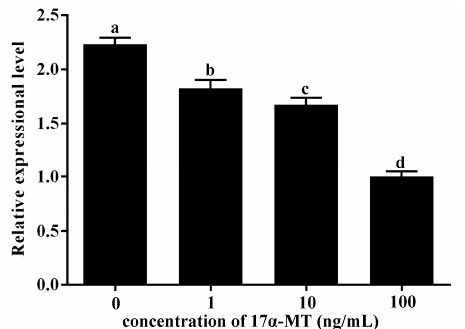
Figure 9. Expression of CYP19A1 mRNA in P. olivaceus testis cells stimulated with 1, 10 and 100 ng/mL 17 α -MT. qRT-PCR analysis was used to quantify CYP19A1 mRNA with β -actin as a reference. The relative expression variance is presented as a ratio (amount of CYP19A1 mRNA normalized to the values of the corresponding reference genes). The data are shown as the mean ± SD ( n = 3). Columns with different letters show a significant difference ( p < 0.05).